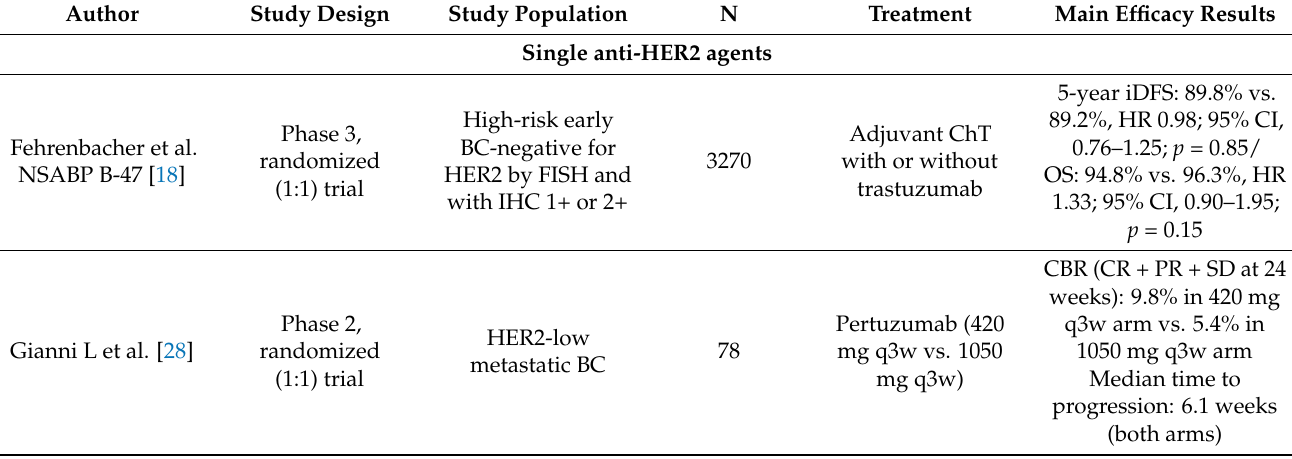
Table 1. Key clinical efficacy data of anti-human epidermal growth factor receptor-2 (HER2) agents in HER2-low BC.